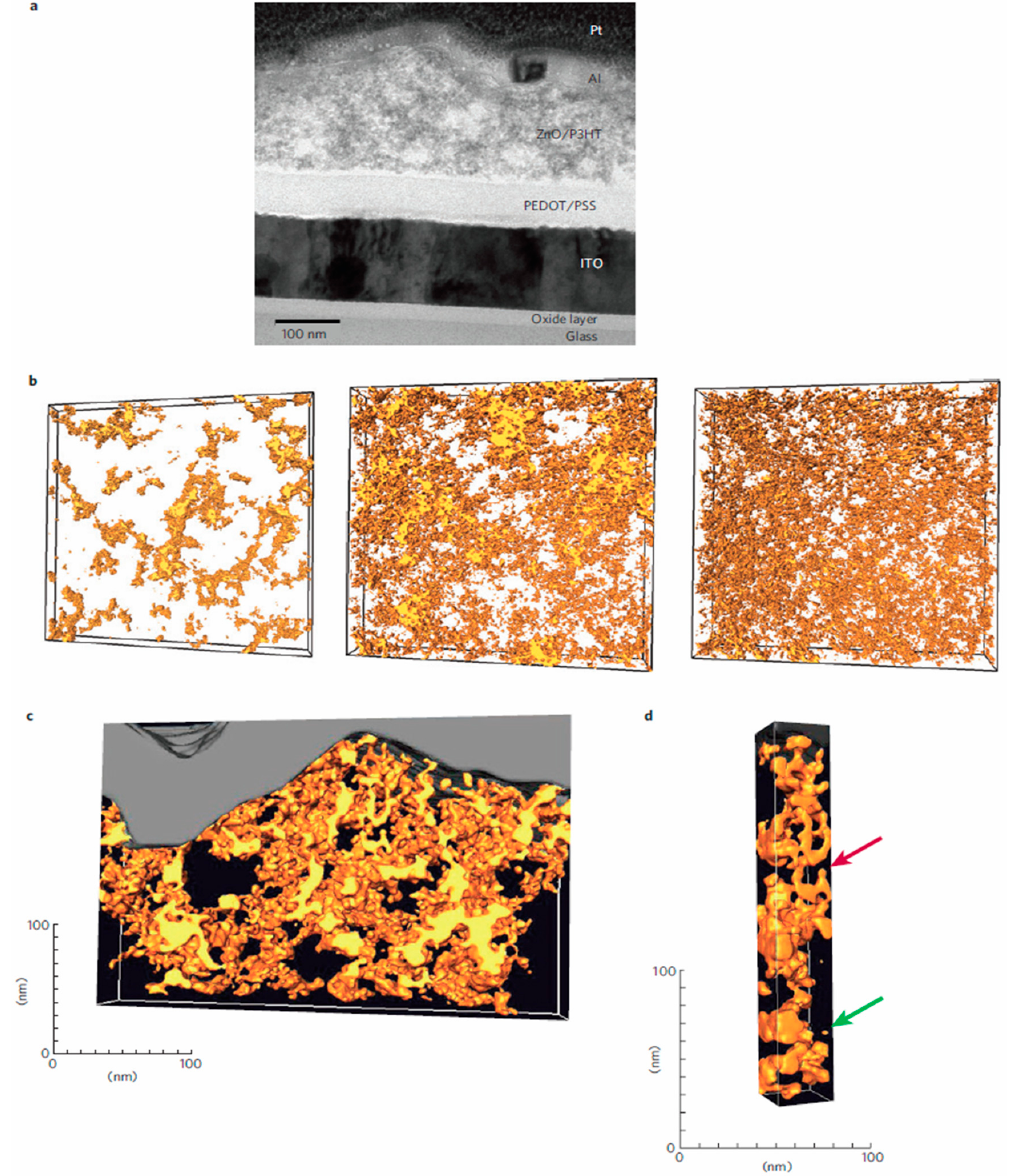
Figure 14. Electron tomography of ZnO/P3HT solar cells. ( a ) TEM image of a cross section of a ZnO/P3HT solar cell. ( b ) Reconstructed volumes of ZnO/P3HT layers. Three samples were analysed, with thicknesses of 57, 100, and 167 nm going from left to right. P3HT is transparent, while ZnO is yellow. ( c ) Reconstructed volume of a cross section of a ZnO/P3HT active layer in a complete device; ( d ) an image demonstrating ZnO domains connected to top but not flowing through to the bottom (red arrow) and an entirely isolated ZnO domain (green arrow). Reprinted with permission from Macmillan Publishers Ltd: Nature Materials [71], Copyright 2009.